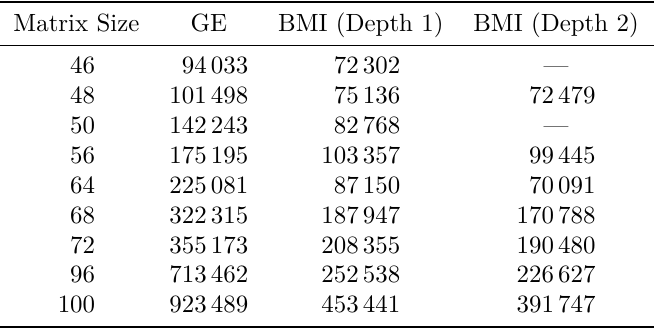
Table 4: Gaussian elimination (GE) vs. Block matrix inversion (BMI) method in CPU